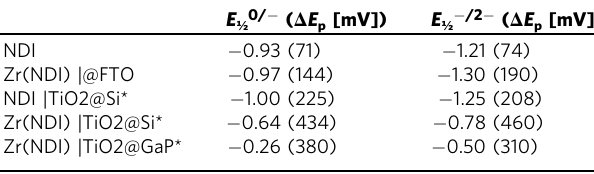
Table 1 (Photo)electrochemical data (volts vs. Fc + /0